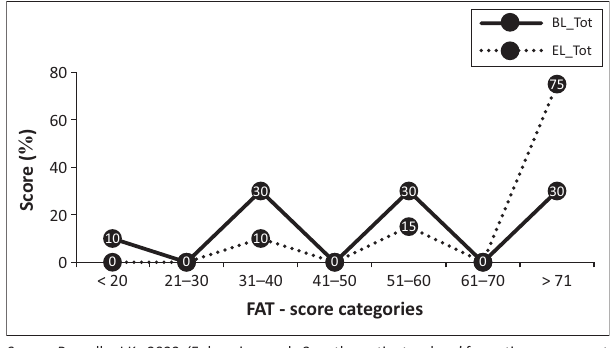
FIGURE 6: Formative assessment techniques frequency score